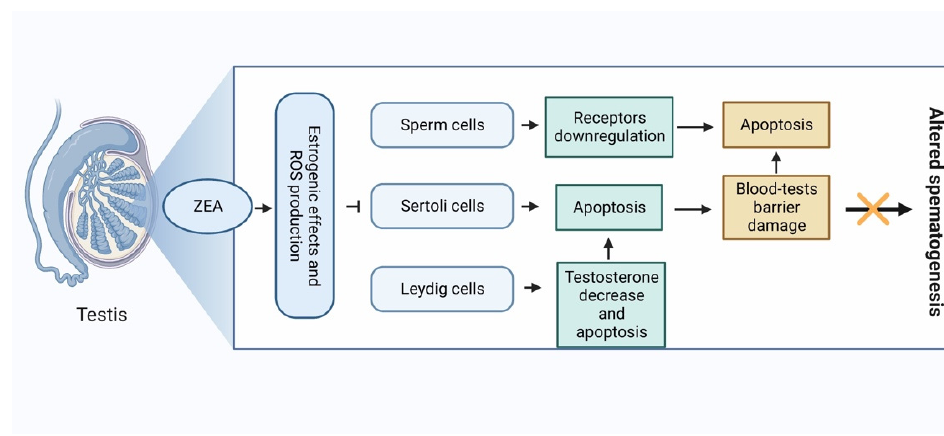
Figure 2. Mechanism of action of zearalenone on male reproductive cells.